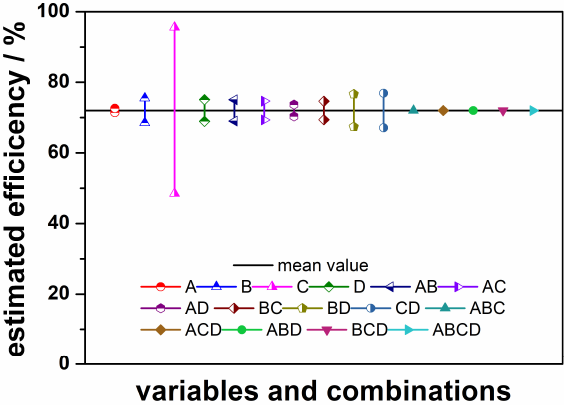
Figure 2. Response plot of the individual and interactive effects of the four selected variables with their three levels on the corrosion protection of steel